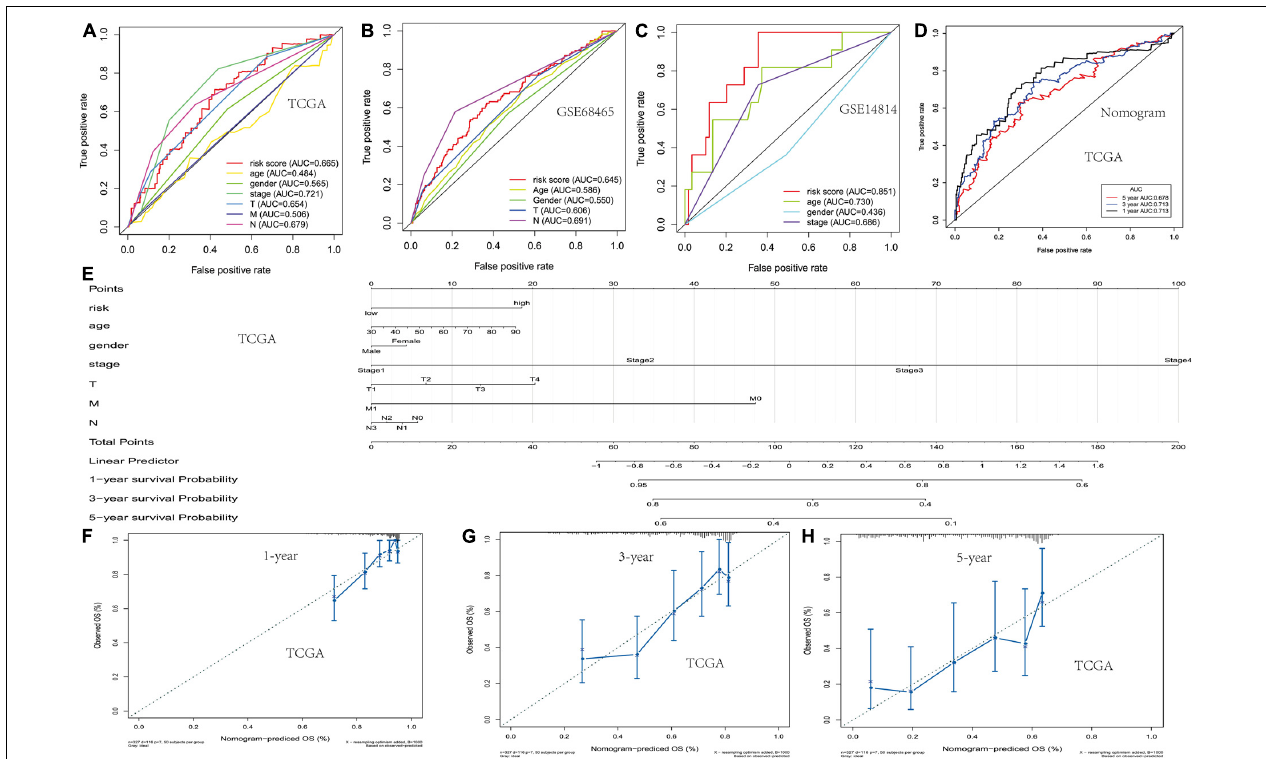
FIGURE 3 | Development of the nomogram based on two PM-related genes and clinical features. (A–C) The receiver operating characteristic (ROC) curve of OS in TCGA and the GSE68465 and GSE14814 cohorts. (D) The ROC curve of the nomogram based on two PM-related genes in TCGA. (E) The nomogram based on two PM-related genes in TCGA. (F–H) 1-, 3-, and 5-year calibration curves of the nomogram in TCGA. PM, platelet and immunity; OS, overall survival; TCGA, Cancer Genome Atlas